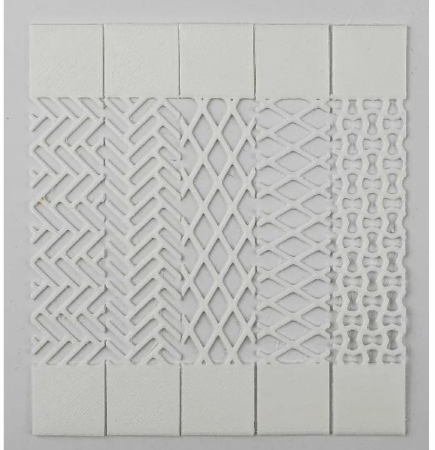
Figure 6. 3D printed pattern-specimens of TPU